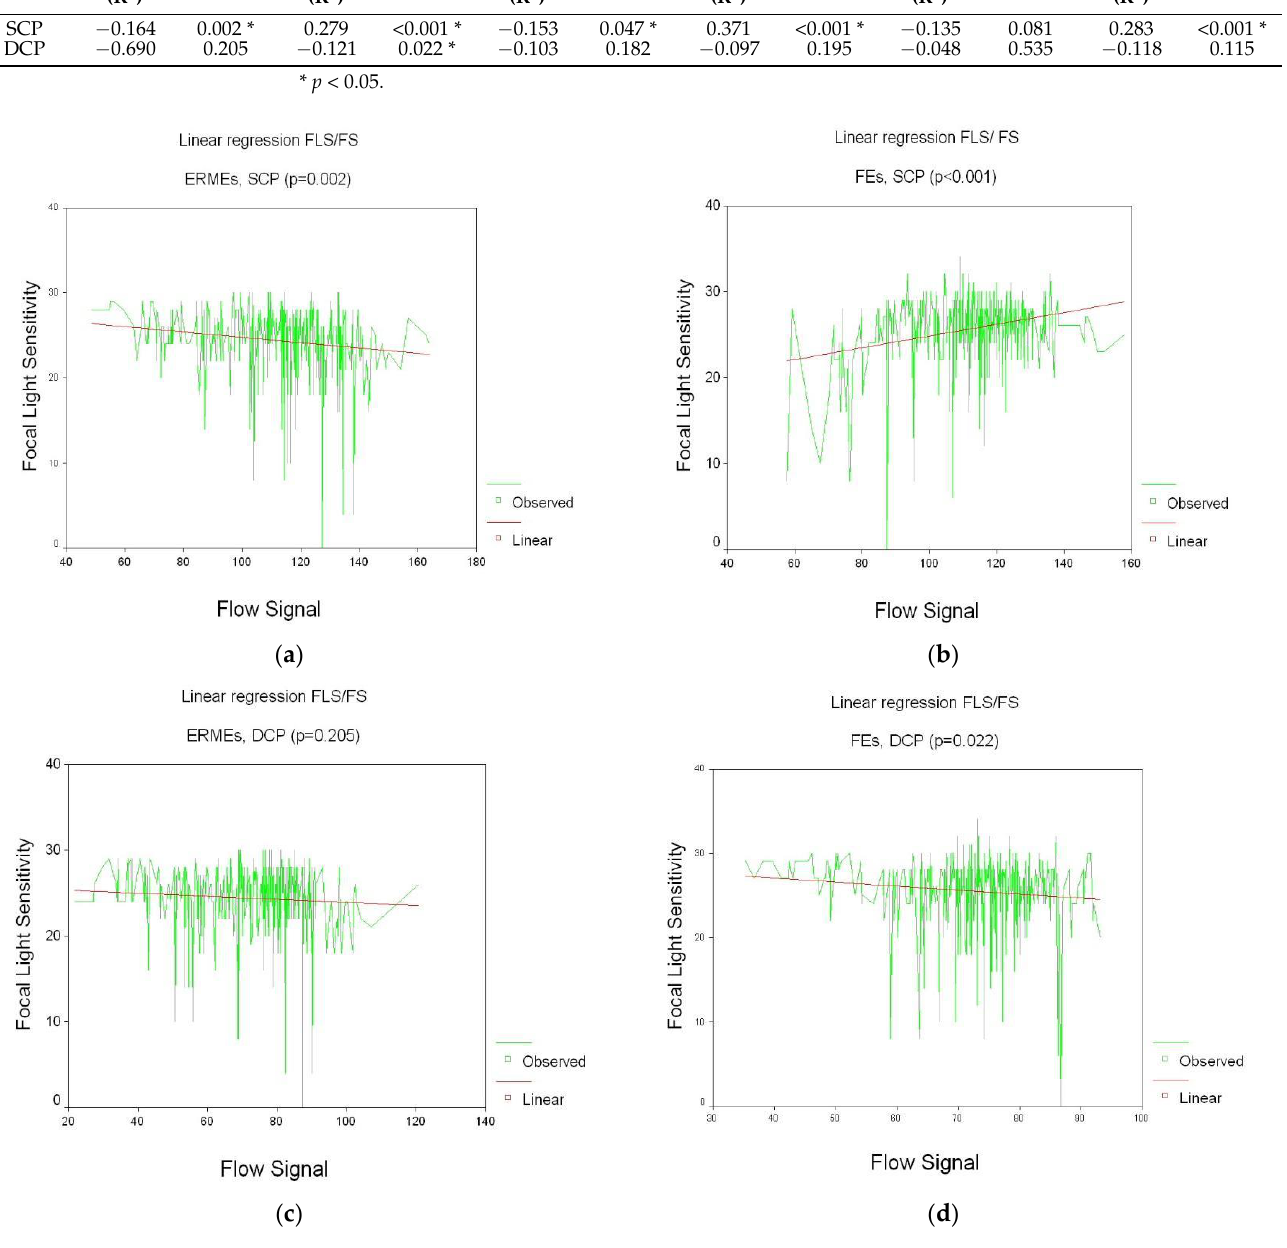
Table 2. Correlations between morphological (SCP, DCP) and functional (FLS) parameters in global, inner and outer